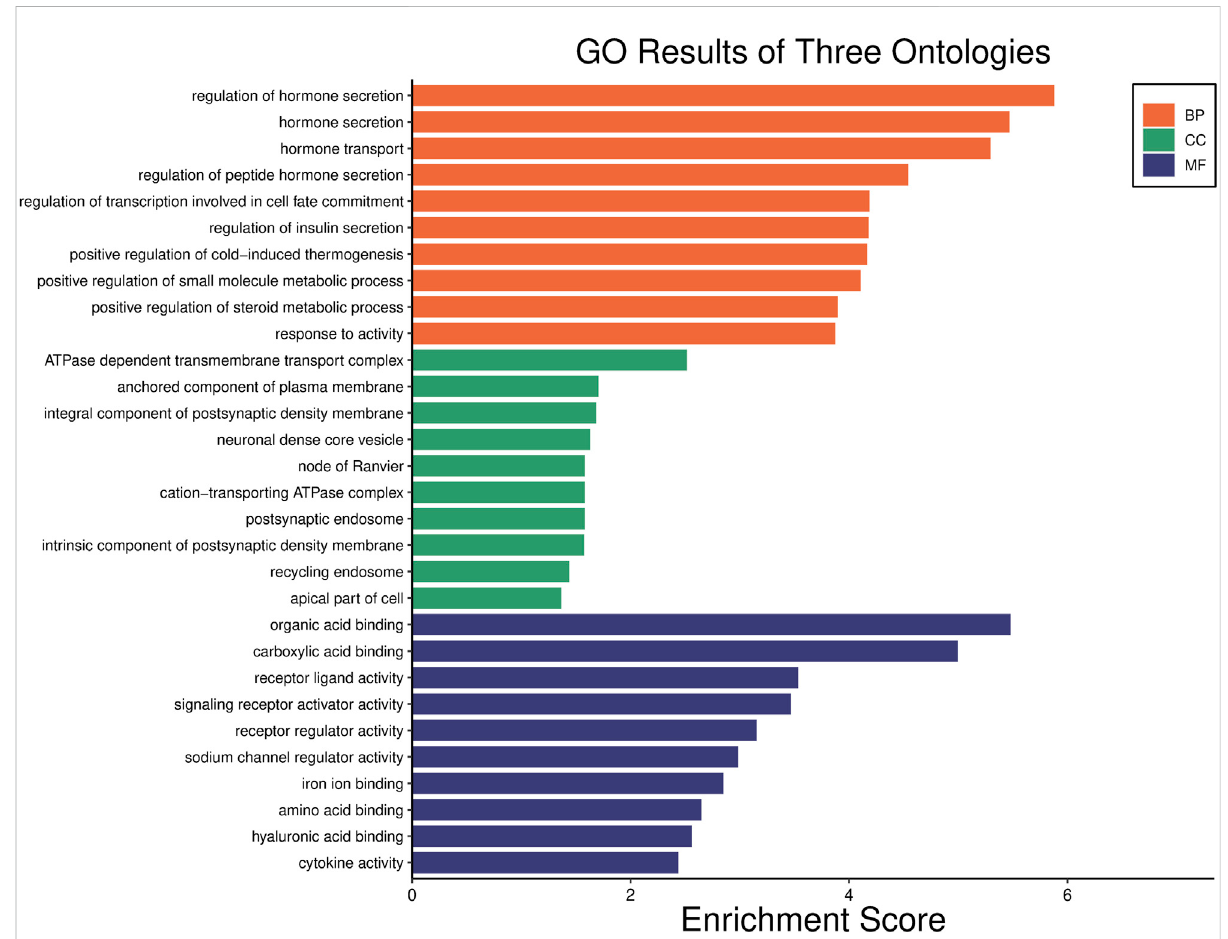
FIGURE 3 Gene Ontology (GO) functional classi fi cation. The signi fi cant GO terms of differentially expressed genes in the T-2 toxin group compared with the control group. The orange, green, and blue bars represent the biological process, cellular component, and molecular function,